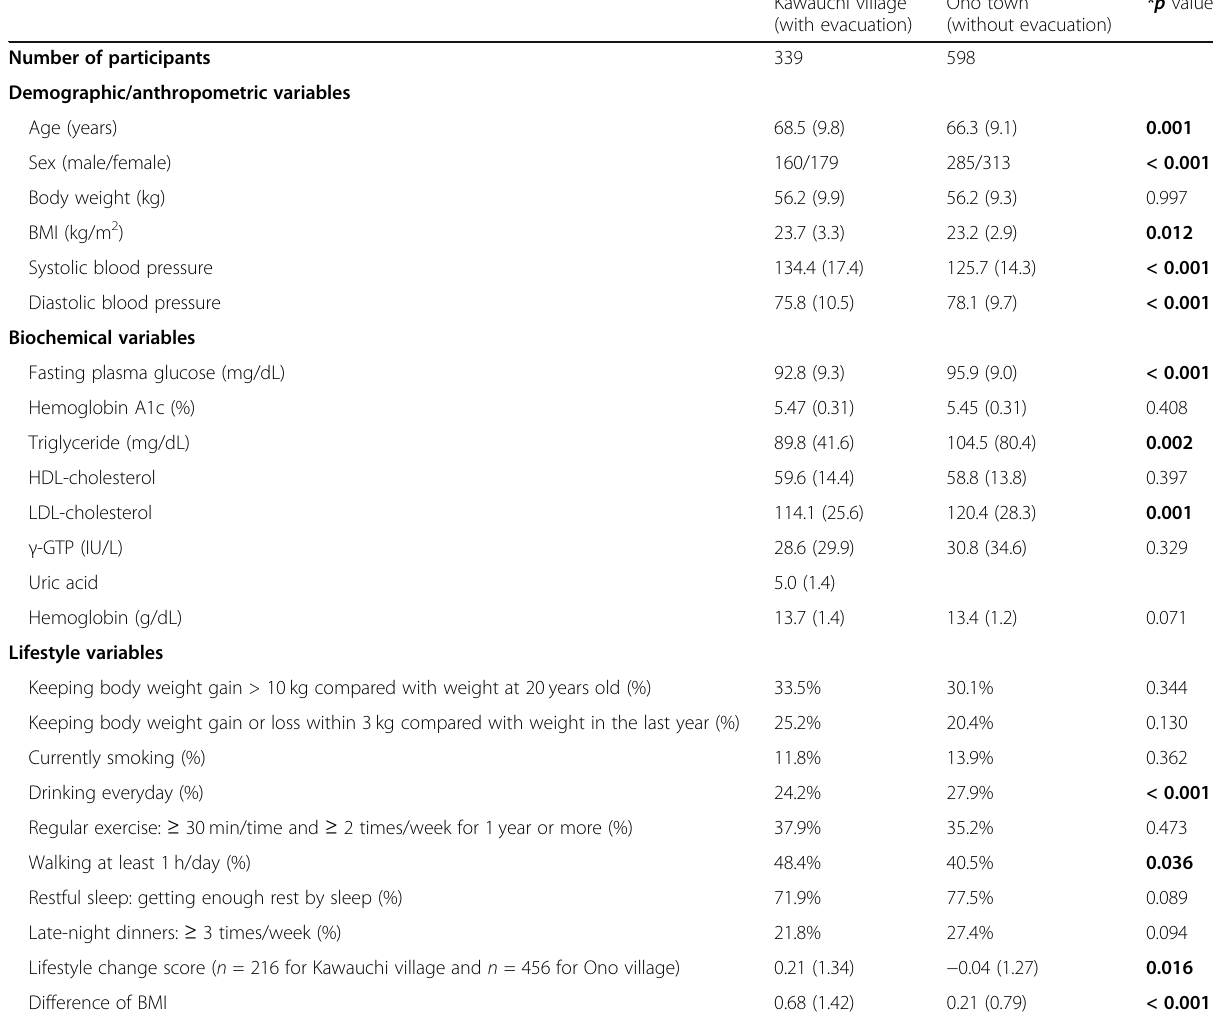
Table 2 Comparison of selected biomedical and health behavioral characteristics and lifestyle change scores between Kawauchi village affected by the 2011 Fukushima Daiichi nuclear plant disaster and Ono town at baseline (2010)